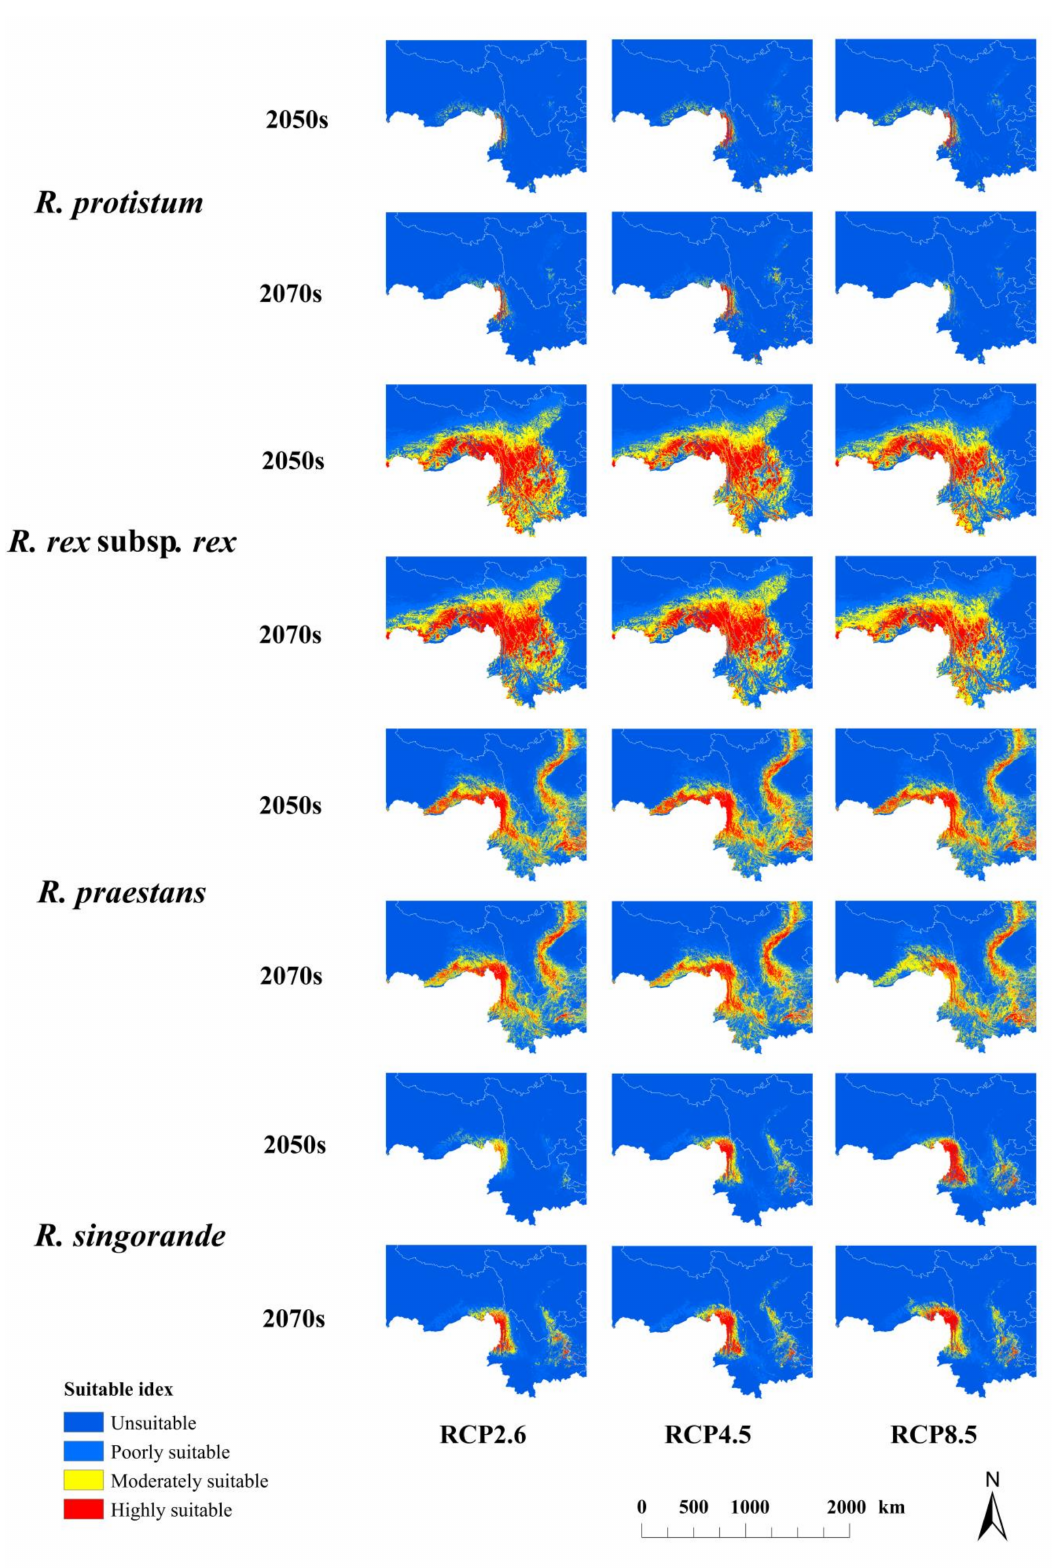
Figure 3. Prediction of the potential distribution of four Rhododendron species in China under different future climatic scenarios (RCP 2.6, RCP 4.5, and RCP 8.5) in the 2050s and